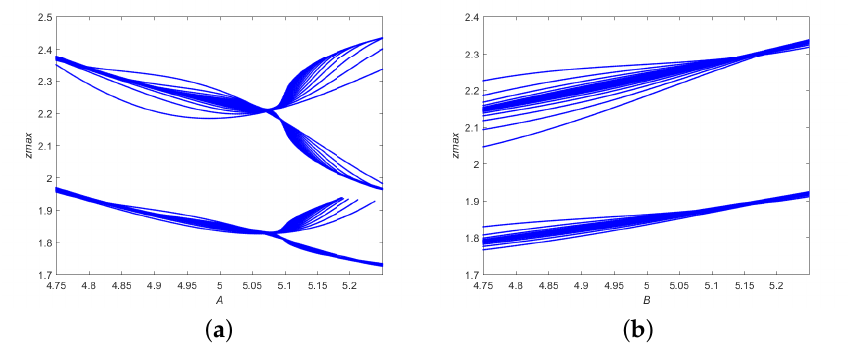
Figure 3. Bifurcation diagram of (1) for ( a ) 4.75 ≤ A ≤ 5.25 and ( b ) 4.75 ≤ B ≤ 5.25.